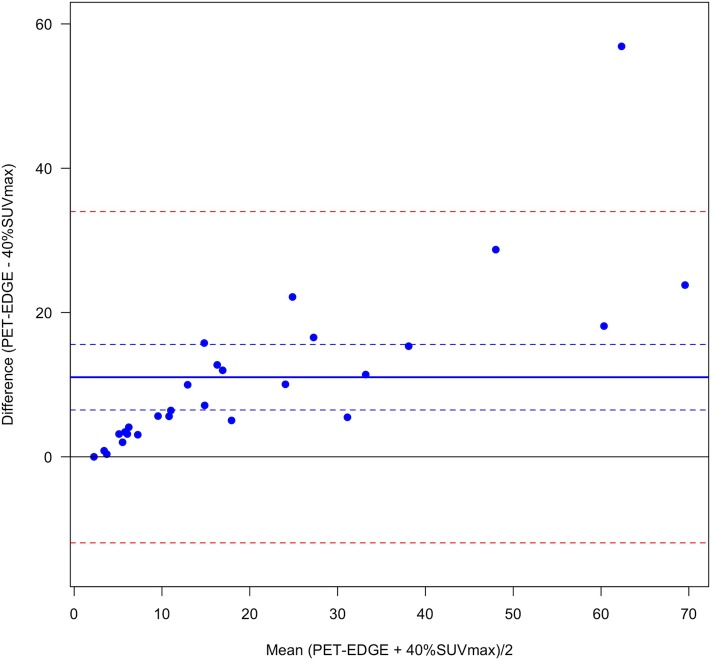
Variability between PET-EDGE and 40%SUVmax method.Bland-Altman plot. (Solid blue line) Bias. (Dashed blue lines) Bias 95% confidence interval. (Dashed red lines) Difference 95% confidence interval.